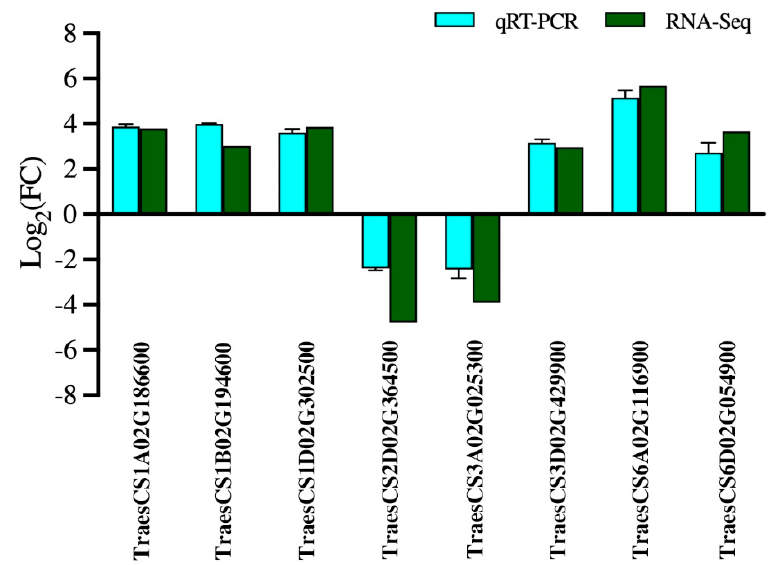
Figure 3. Transcript levels of selected genes and the corresponding expression data of RNA ‐ Seq. The cyan columns represent relative expression obtained by qRT ‐ PCR, and the green columns represent relative expression obtained by RNA ‐ Seq.